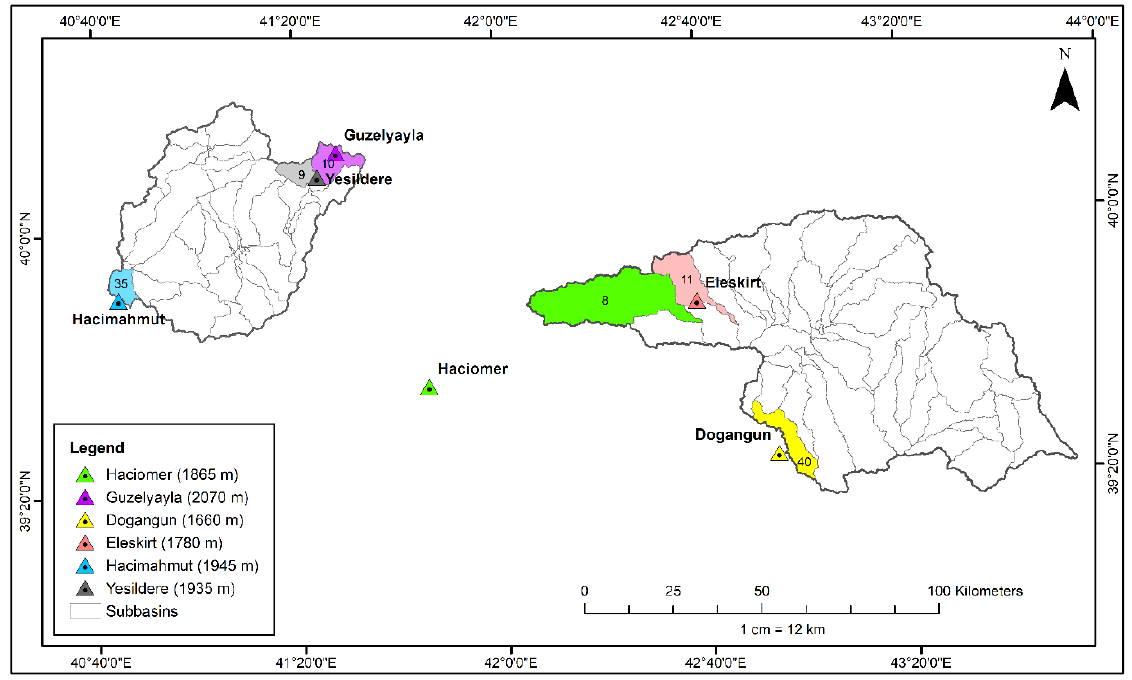
Figure 7. Location of snow stations with corresponding subbasins.